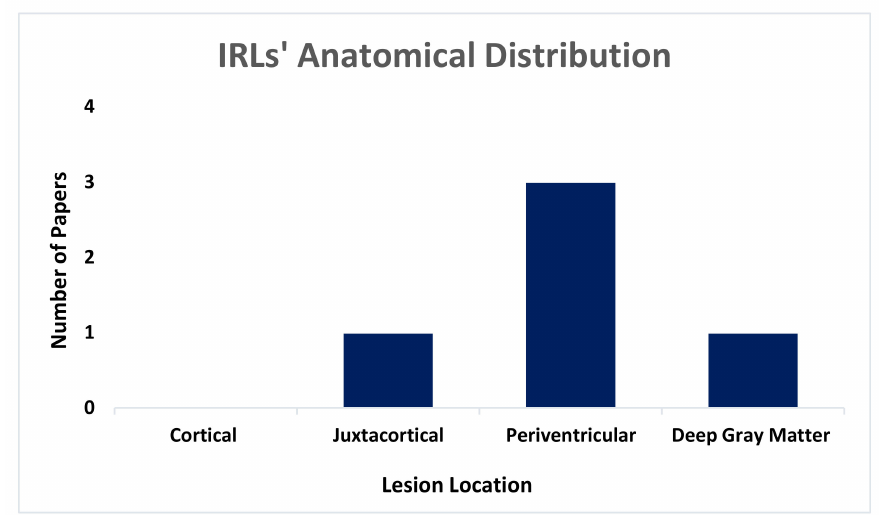
Figure 3. Illustrates the main anatomical location of the IRLs in MS lesions when reported (total of 5 papers).